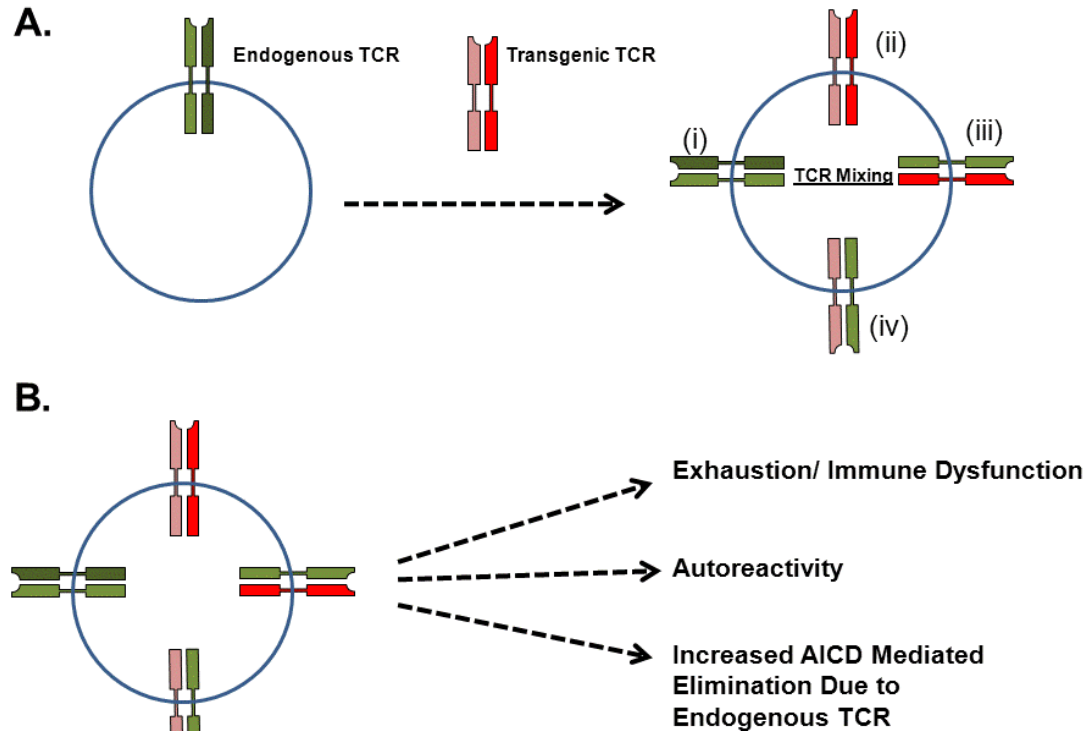
FIGURE 3. Cartoon showing the limitations of the TCR engineering approach. (A) Possible novel hybrid TCR sets created by mixing of the α- and β-chains of the endogenous TCR and the transgenic TCR. Such mixed TCR-expressing immune cells could exhibit a potentially harmful autoreactivity, depicted in Fig. 3B. (B) TCR-engineered cells are also susceptible to the historic barriers of cancer immunotherapy; for example, the tumor microenvironment–mediated immune dysfunction and the epitope-specific AICD- mediated premature